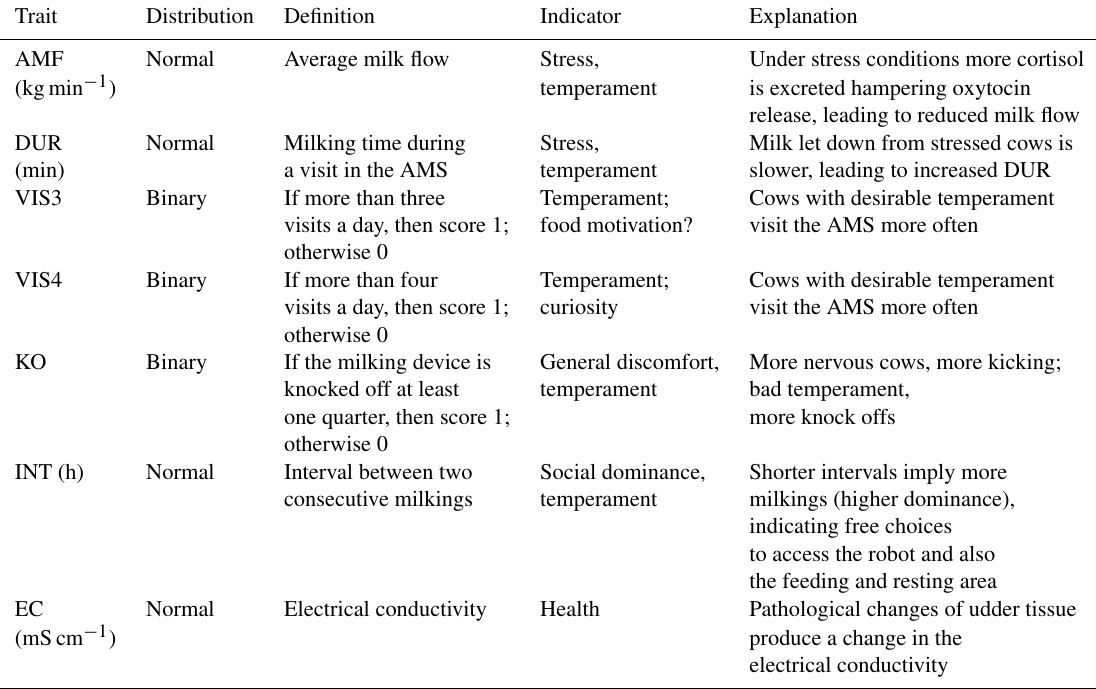
Table 1. Definition of the traits generated in the AMS and an explanation for their use as behavior and health trait indicators. Trait Distribution Definition Indicator Explanation Average milk flow Stress, Under stress conditions more cortisol